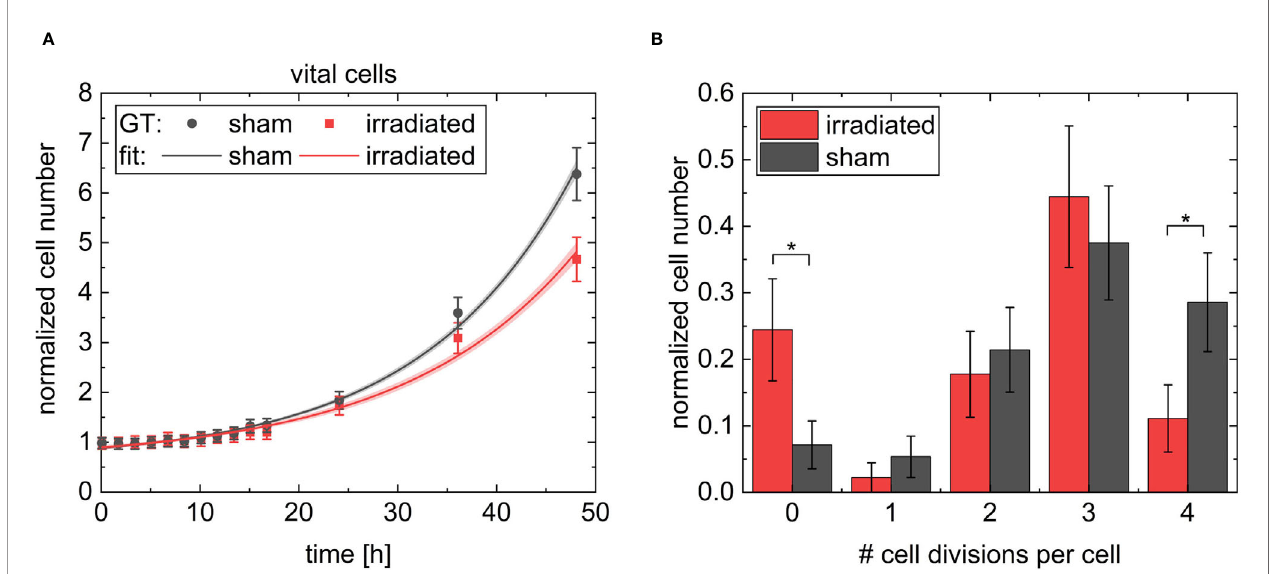
FIGURE 10 | In (A) the normalized cell numbers of the vital cells of the ground truth data are shown with dots, the black rectangular dots for the sham sample and red circular dots for the irradiated sample. The data were fi tted by exponential growth and indicated as lines. In light red and grey the 63 % con fi dence band is shown. In B the number of cell divisions per each cell on the two videos followed for 48 h is shown. The results for the irradiated sample are indicated with red bars and for the sham sample with black bars. Errors in (A, B) were derived from Poisson statistics. * indicates a p-value <